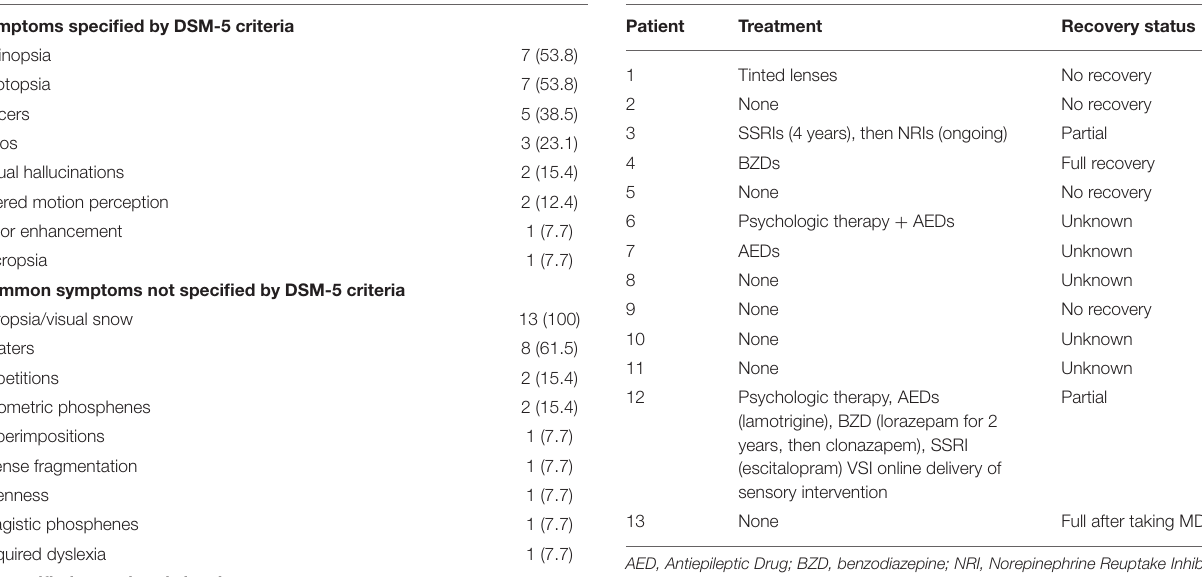
TABLE 3 | Frequency of visual symptoms amongst HPPD cases ( n , %). TABLE 4 | Treatment and recovery status of HPPD